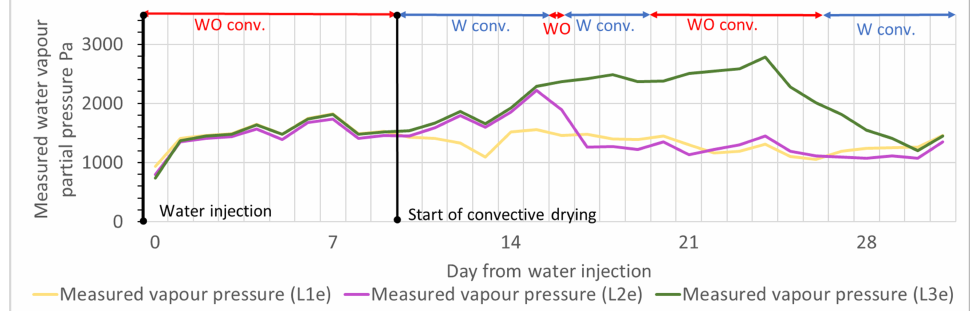
Figure 6. Daily running average of measured water vapour pressures in convective drying wall